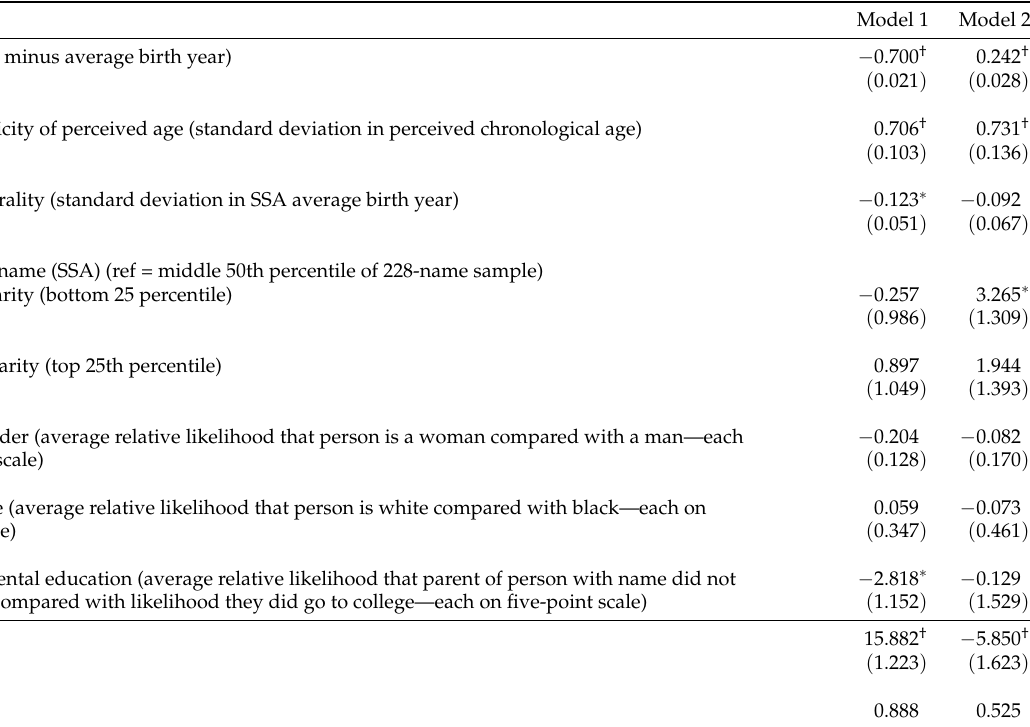
Table 4: Ordinary least squares regression predicting perception “error”: the difference between perceived age and expected real-world age from birth records